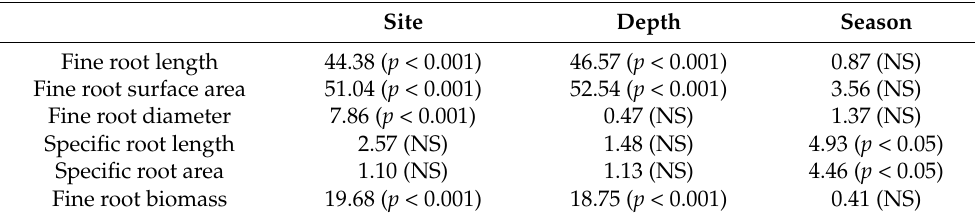
architecture traits in three riverside